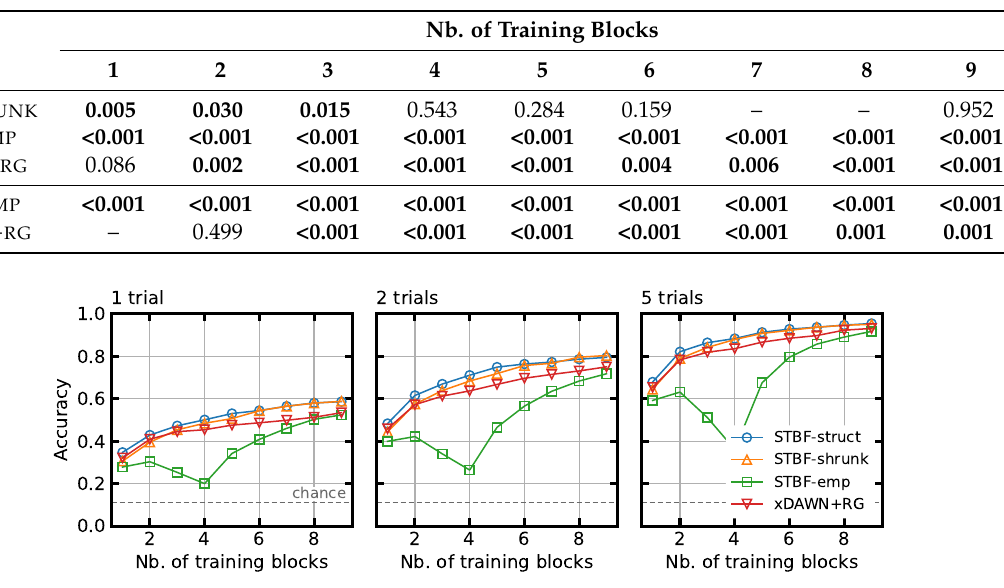
Figure 3. Accuracy of the different classifiers for all 21 subjects relative to the number of blocks available for training. One block consists of 135 epochs and corresponds to 27 seconds of stimulation. Accuracies are shown for the evaluation settings averaging over 1, 2, and 3 trials of testing stimuli. Figure A1 contains results for all numbers of trials. Although STBF - EMP is unstable when few training data are available, regularization of the covariance matrix ( STBF - SHRUNK and STBF - STRUCT ) drastically improves